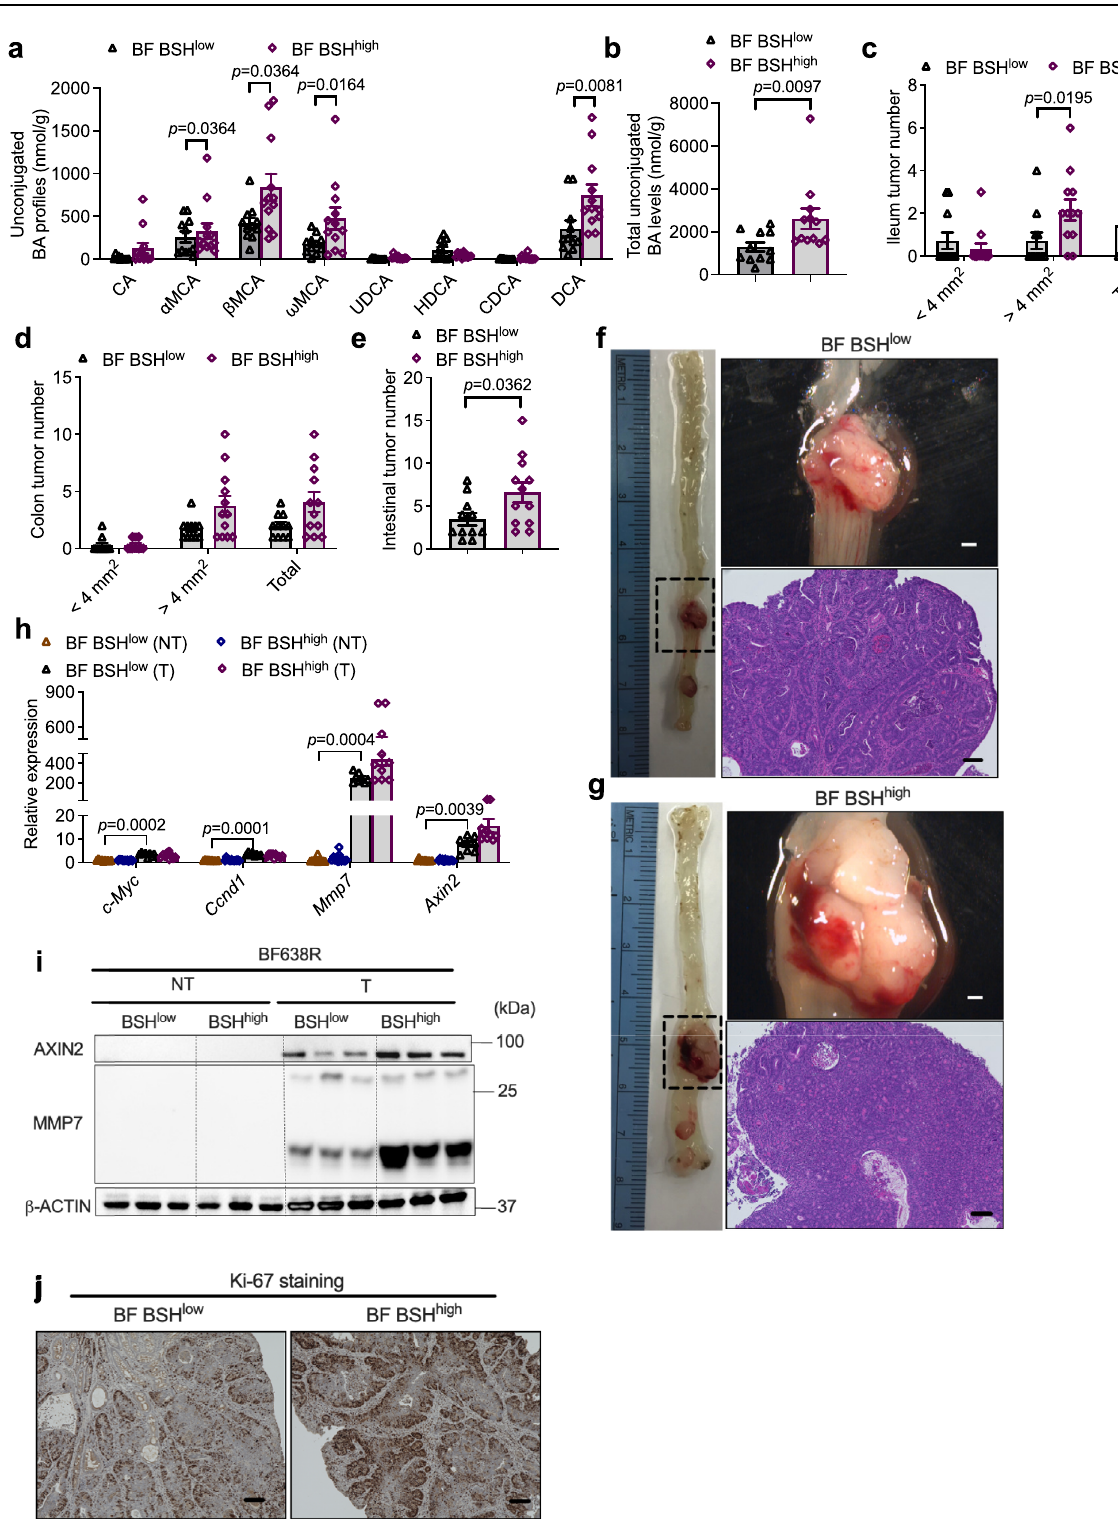
Fig.5|MicrobialBSHoverexpressionin B.fragilis potentiatesCRCprogression. a – h HFD-fed Cdx 2 Apc f/w mice were colonized with BF BSH low or BF BSH high for 12 weeks ( n =11 mice for BF BSH low ; n =12 mice for BF BSH high ). Unconjugated bile acid pro fi les ( a ) and total unconjugated bile acid levels ( b ) in the colon contents. Mann – Whitney U test with two-sided ( a ).Two-tailed Student ’ s t test ( b ). The ileum ( c ) and colon ( d ) tumor incidence, and tumor numbers with different sizes (<4mm 2 ,>4mm 2 andthesumofboth.Mann – Whitney U testwithtwo-sided. e Total tumor numbers in the intestine. Two-tailed Student ’ s t test. f , g Representative pictures of colon (left), gross images of tumors (top right) in the colon and H&E